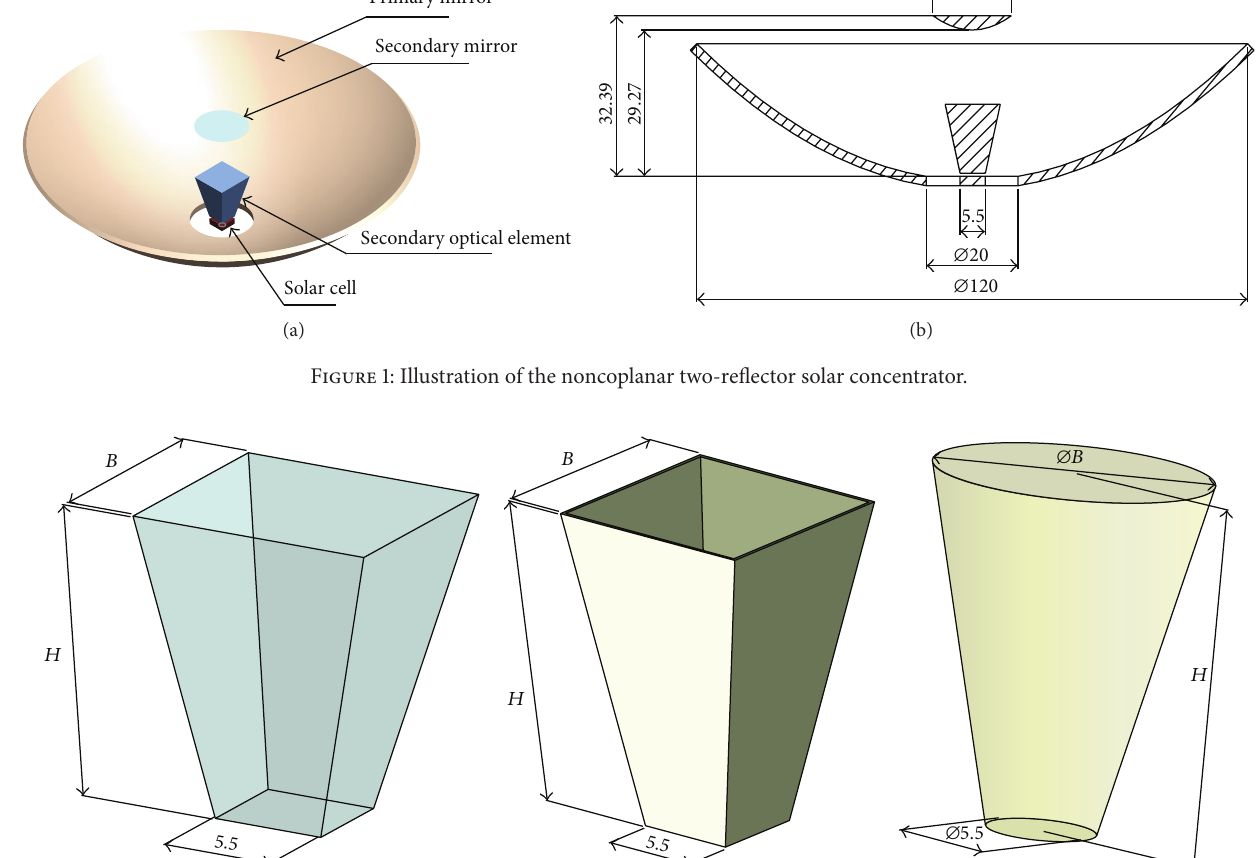
parameters of the two mirrors were preliminarily